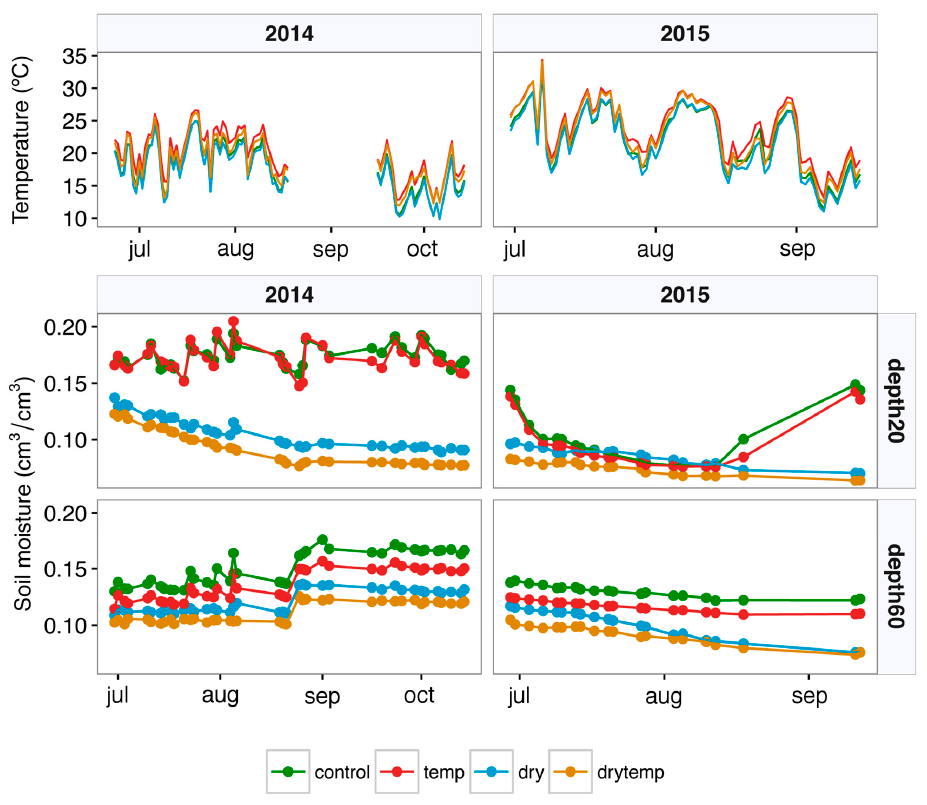
Figure 1. Climate conditions during the two treatment periods in 2014 and 2015. Mean daily temperatures are shown in the upper panels. Middle and lower panels display soil moisture at 20 and 60 cm depth, respectively. Abscissas labels are placed at the beginning of the month.